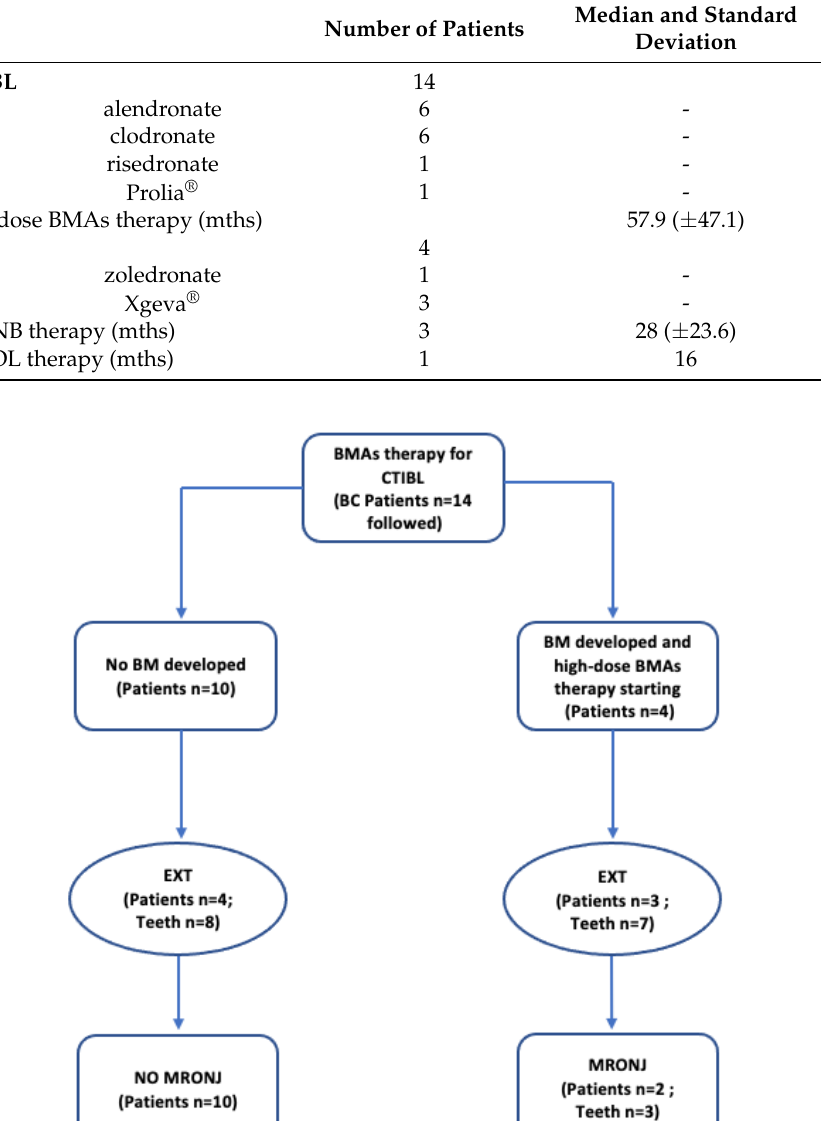
development after teeth extractions was diagnosed in 14 patients with breast cancer. Four patients developed BM and switched from low dose BMAs to high dose BMAs. Three of these patients